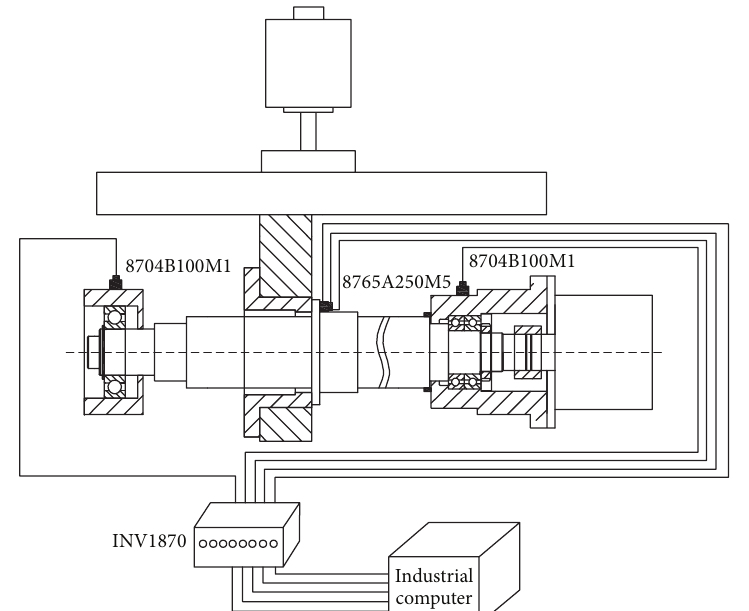
Figure 1: Screw online monitoring system.